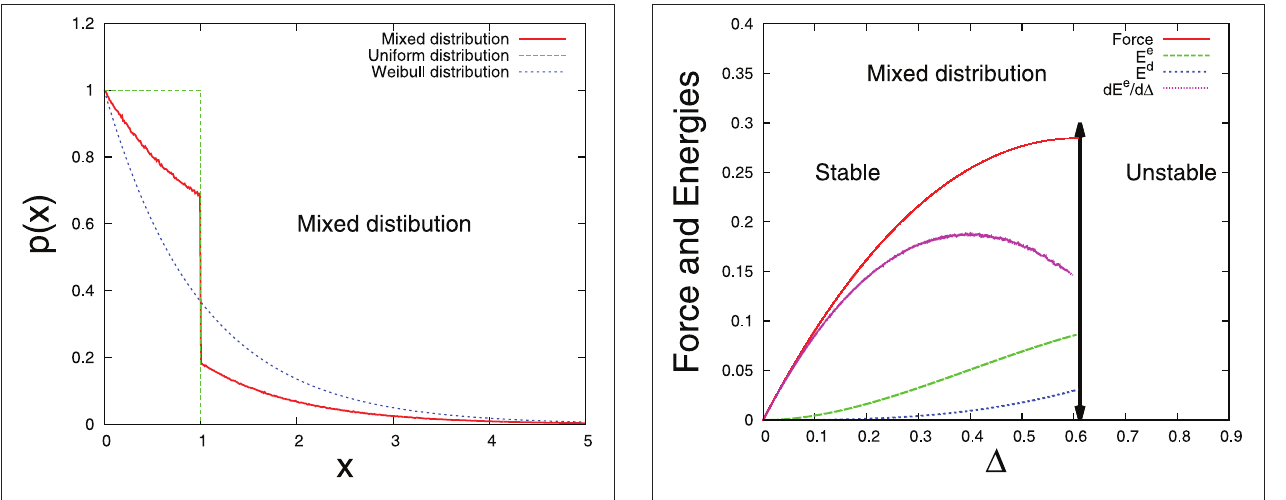
FIGURE 10 | A mixture of uniform and Weibull ( k 1) distributions. FIGURE 11 | Force and elastic energies vs. extension 1 for a fiber bundle = (10 7 fibers) with a mixed distribution of